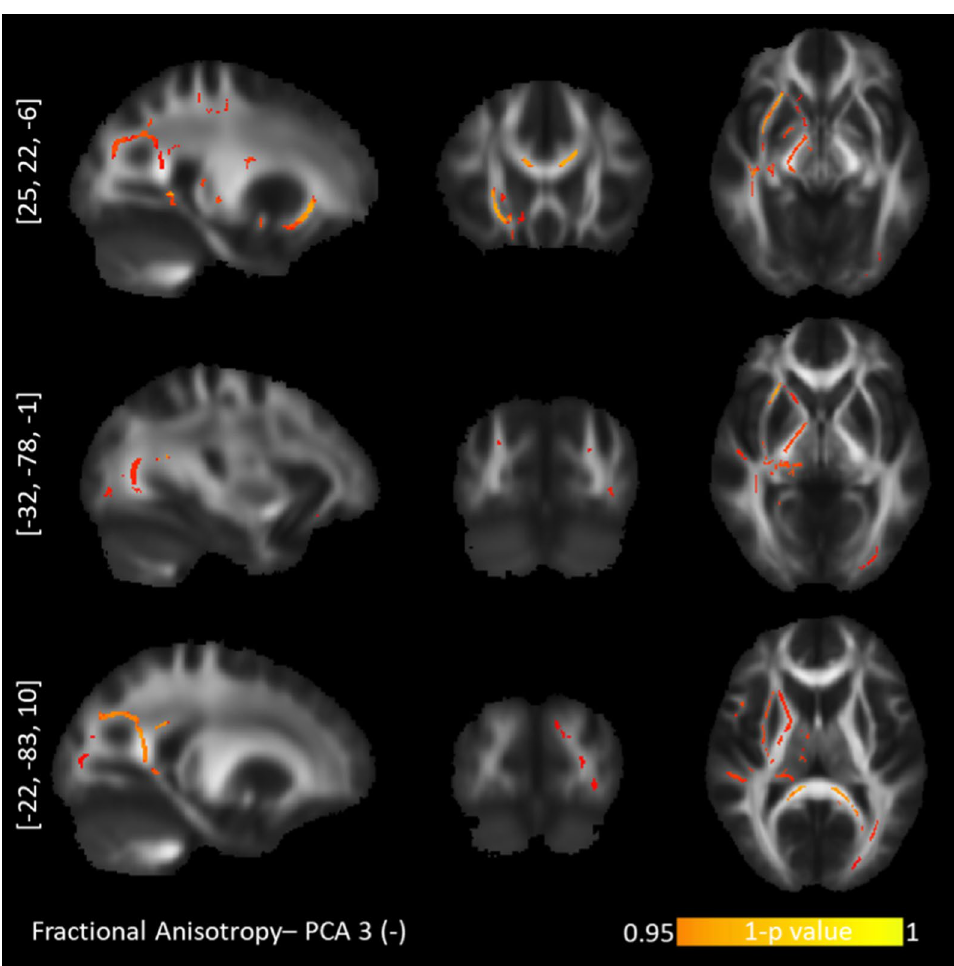
Figure 3. TBSS negative correlations between fractional anisotropy and the "Short-term approach behavior" personality profile. Upper row: inferior fronto-occipital fasciculus. Middle row: inferior longitudinal fasciculus/ posterior corpus callosum. Bottom row: inferior longitudinal fasciculus/posterior corpus